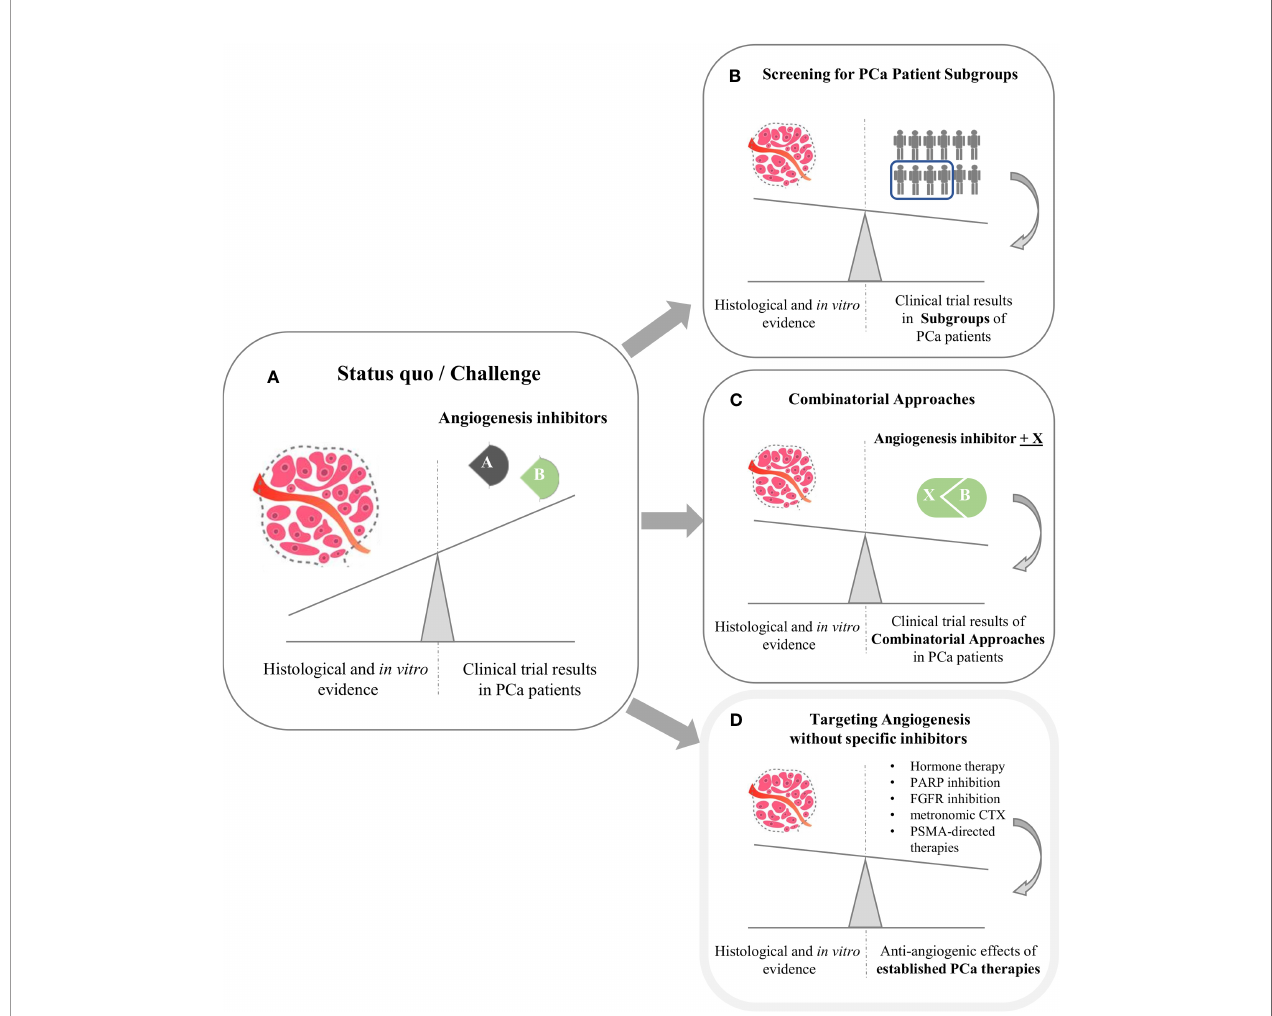
FIGURE 1 | The clinical challenge of angiogenesis inhibition in Prostate Cancer (PCa). (A) Despite promising preclinical evidence from histopathological and in vitro analyses, phase III clinical trials with angiogenesis inhibitors failed to meet clinical endpoints. (B, C) Main strategies aiming to leverage the impact of angiogenesis inhibition are biomarker-aided identi fi cation of PC patient subgroups most susceptible towards anti-angiogenesis (B) and combinatorial approaches (C) . Moreover, several established PCa therapies partly exhibit anti-angiogenic effects as mode of action (D)